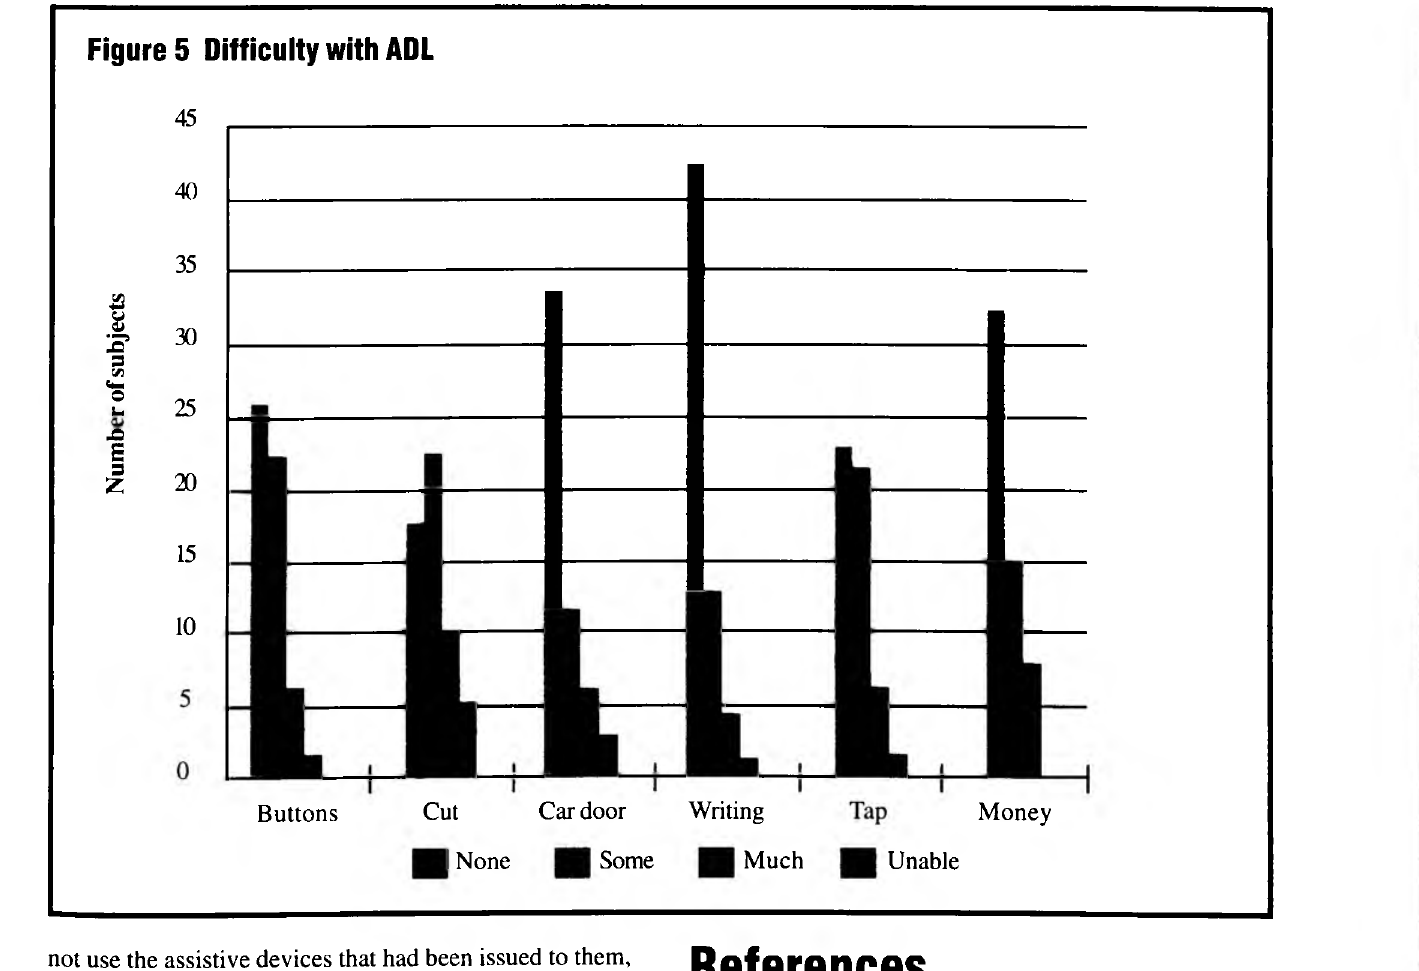
Figure 5 Difficulty with